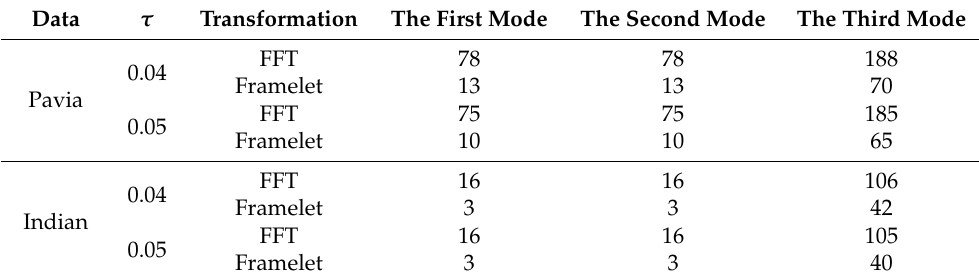
Table 1. The mean value of fibered rank for three orders by using a different transform. Data